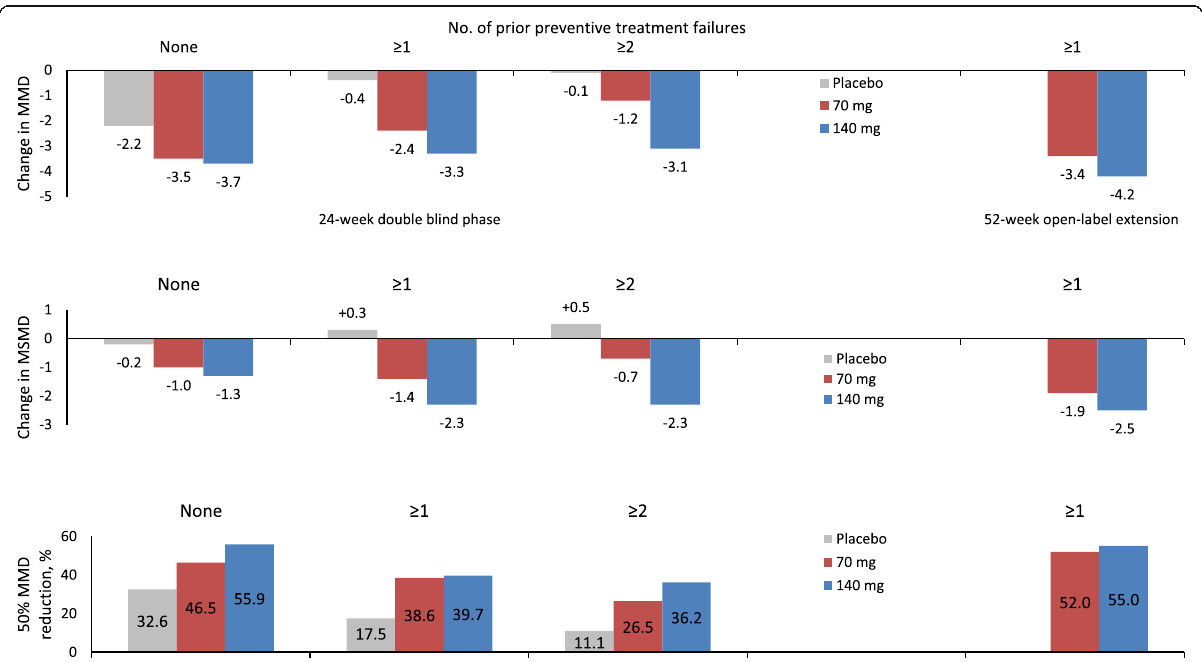
Fig. 1 Patients with episodic migraine: effect of erenumab on monthly migraine days, monthly migraine-specific medication days, and 50% reduction in monthly migraine days from baseline according to prior preventive treatment failures in the STRIVE trial [15] and its open-label extension [16]